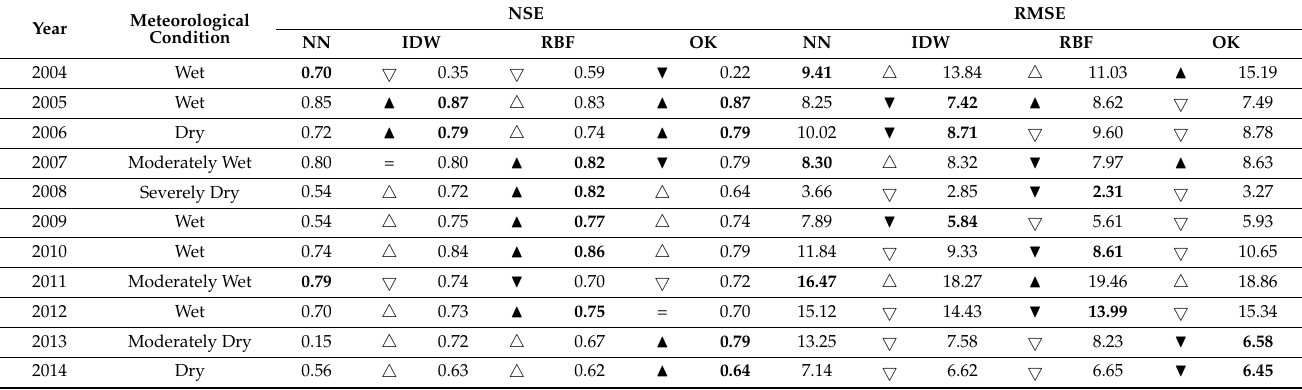
Table 3. Annual summary of RMSE , and NSE values for daily streamflow simulations based on